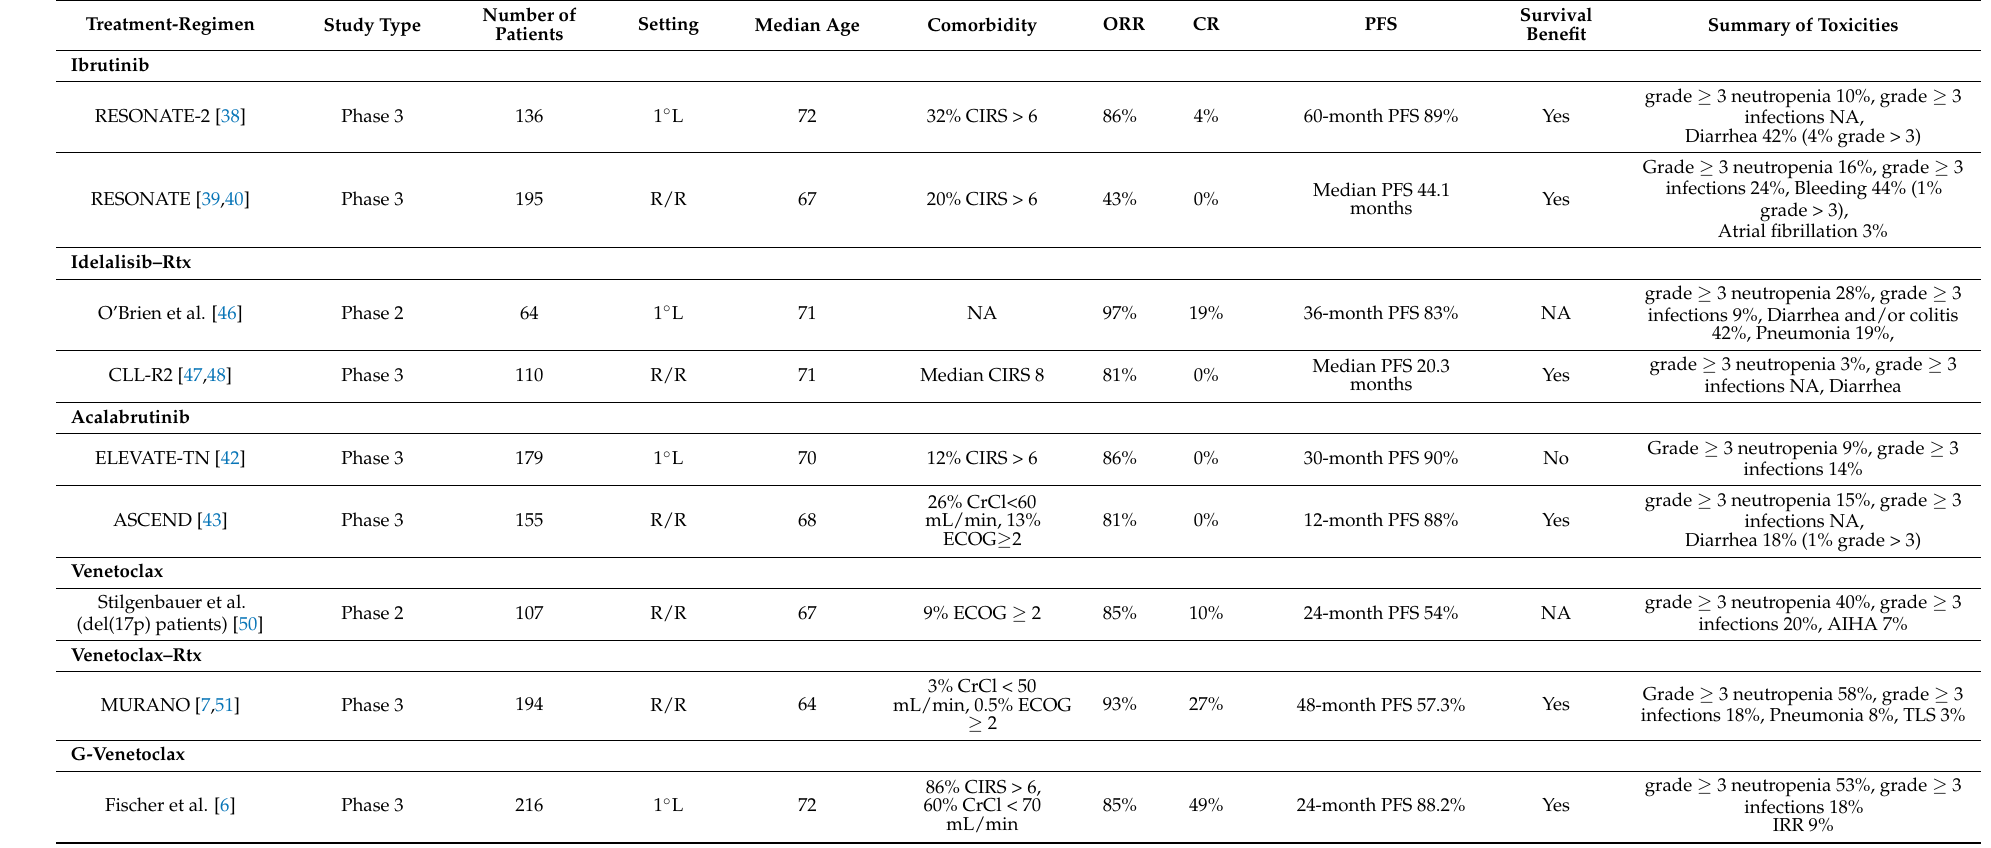
Table 2. Currently available evidence from trials of selective inhibitors in elderly patients with